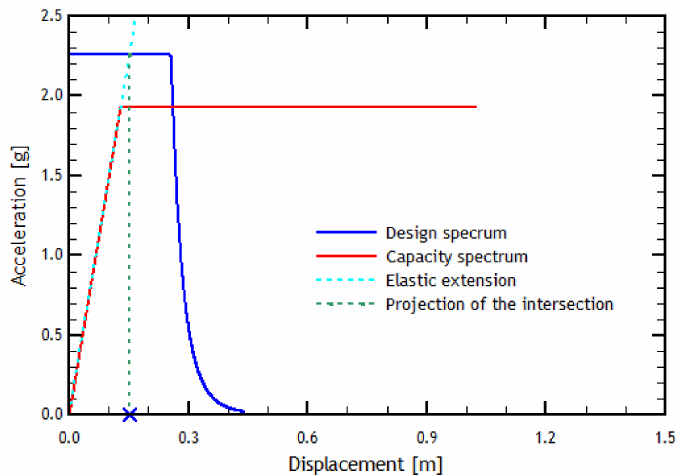
Figure 8. Determination of the performance point using the N2 method in the longitudinal direction. The blue cross represents the Performance Point displacement.